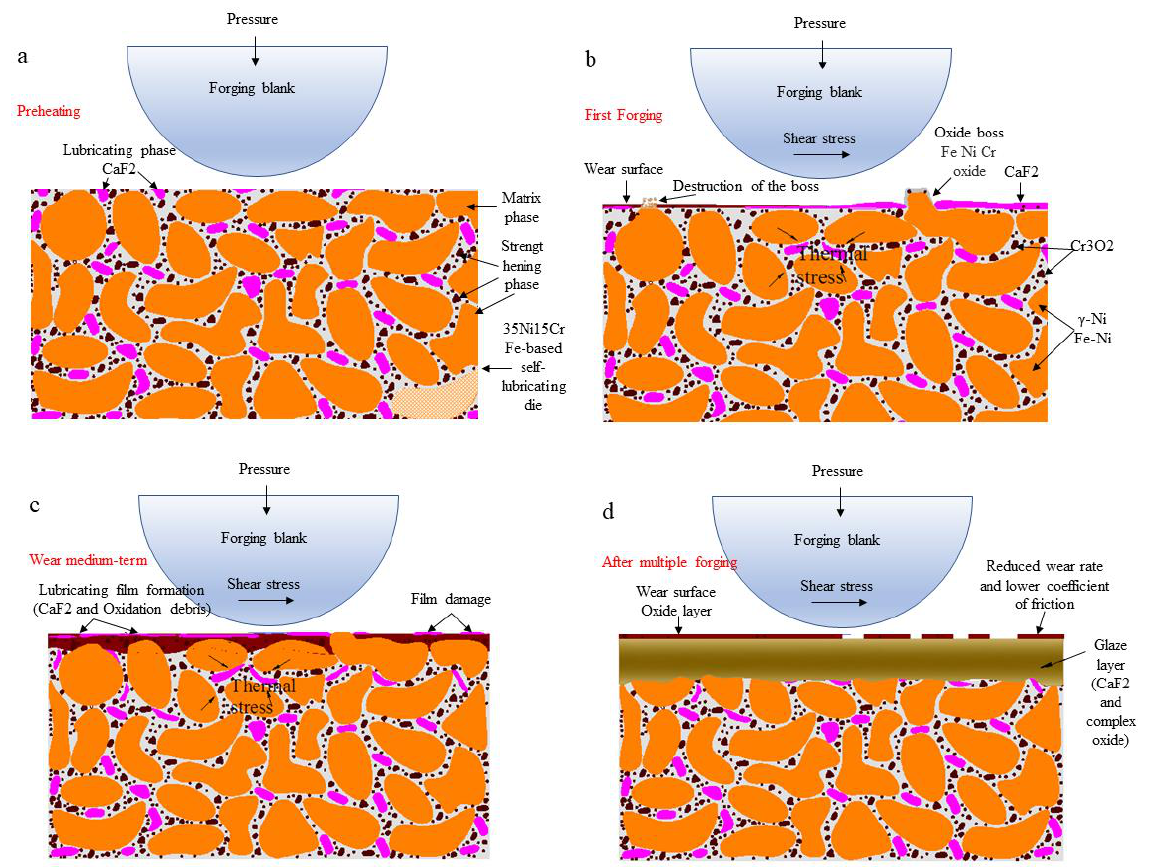
Figure 9. Schematic illustration for the wear mechanism of the 35Ni15Cr Fe-based self-lubricating die materials at varied period. ( a ) preheating; ( b ) first forging; ( c ) Wear medium-term; ( d ) After multiple forging.